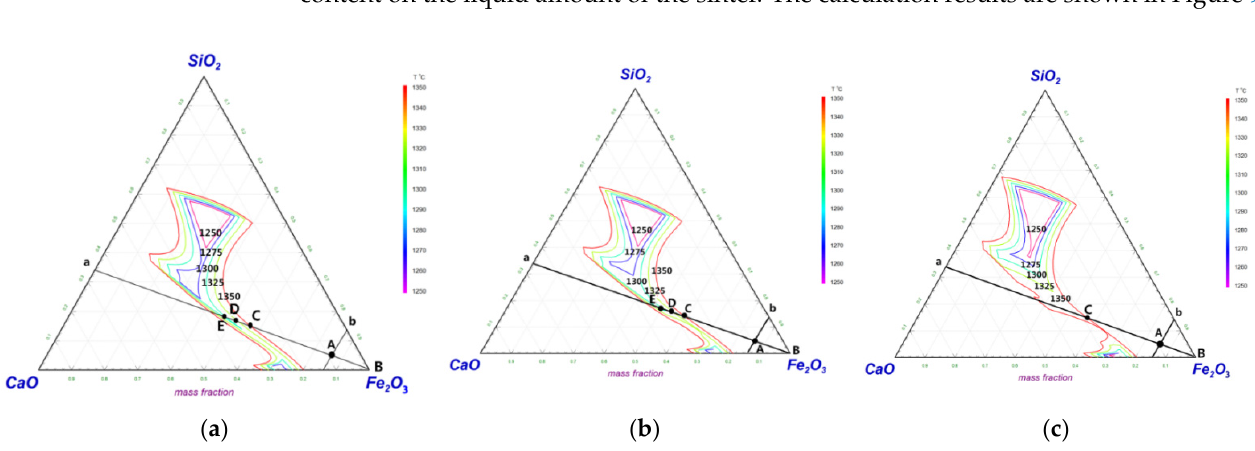
Figure 9. Liquid region of the CaO ‐ SiO 2 ‐ FeOx ‐ Al 2 O 3 ‐ MgO system. ( a ) Al 2 O 3 content of 1.5%; ( b ) Al 2 O 3 content of 1.8%; ( c ) Al 2 O 3 content of 2.1%.